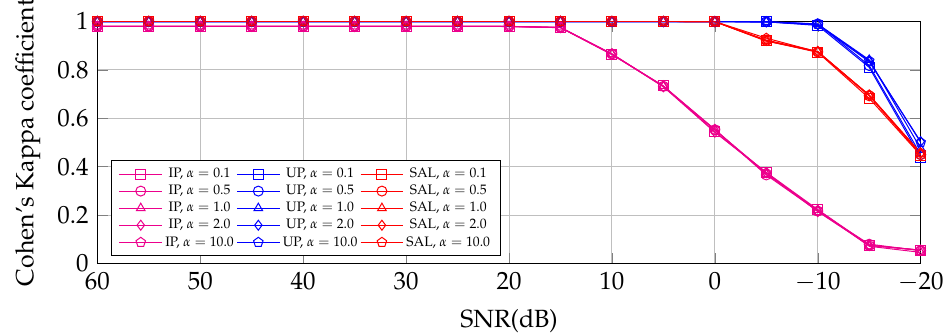
Figure 10. Cohen’s Kappa coefficient obtained by the prediction of the 3DCNN DL model over raw noisy data, trained with 15% of the noise-free data of IP, UP, and SAL, without TKD. UP shows the highest Cohen’s Kappa coefficient values until − 20 dB; after that SAL and IP are the lowest.